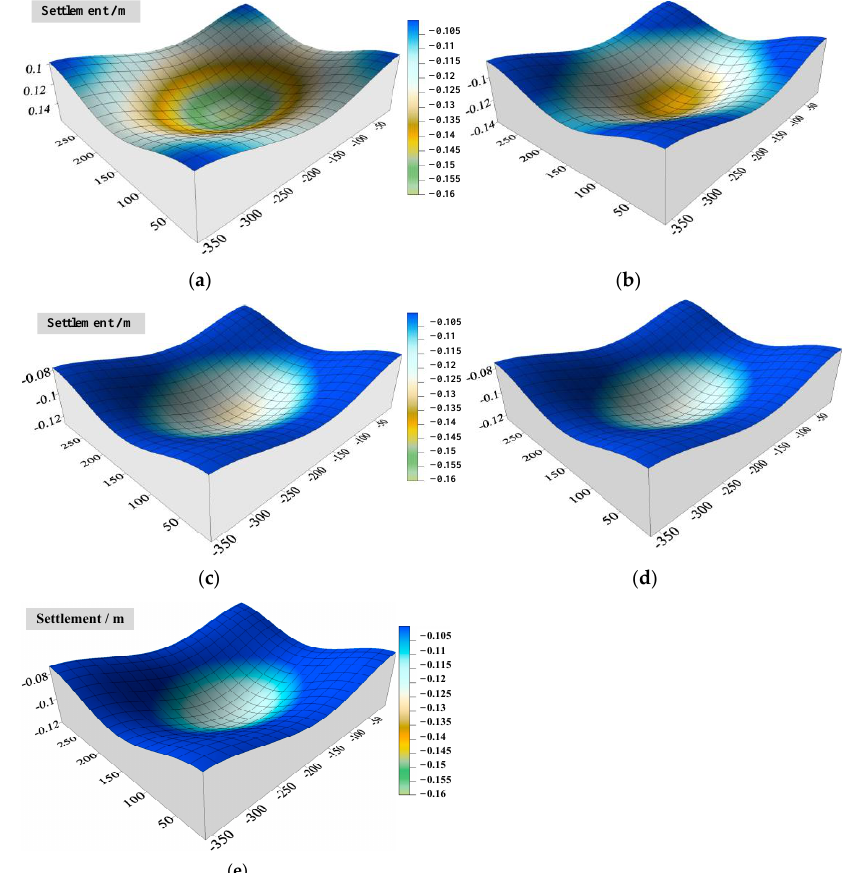
Figure 5. Stress distribution map of backfilling support model for multi-arch pier-column numerical simulation: ( a ) No infill; ( b ) two pier-columns; ( c ) four pier-columns; ( d ) six pier-columns; ( e ) eight pier-columns.